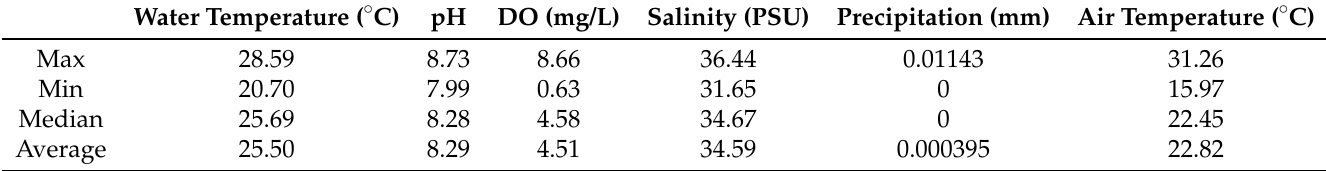
Table 1. The basic characteristic values of the predicted water quality